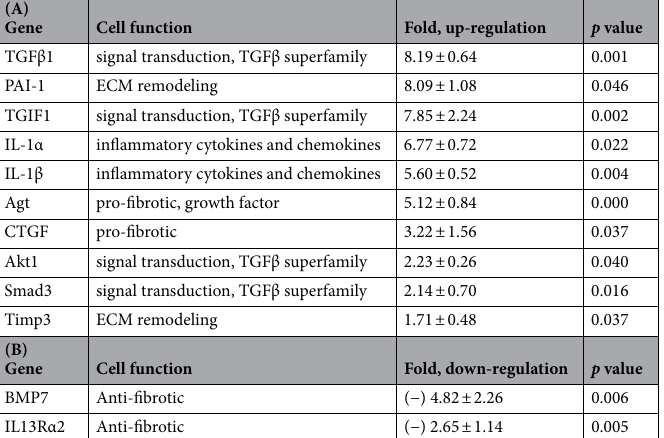
Table 2. Repletion of vitamin D modulates muscle fibrotic gene expression in CKD mice. Gastrocnemius muscle was used for differential fibrosis gene profiling using Qiagen PCR Array Mouse Fibrosis Catalog no. 330231 PAMM-120ZA. Muscle expression of a total of 84 genes important for fibrosis was compared between CKD mice (n = 4) and sham control mice (n = 4). Detailed information for 84 genes is listed in Supplemental Table 2S. Data are expressed as mean ± SEM (Table 2A). Subsequently, sham and CKD mice were treated with